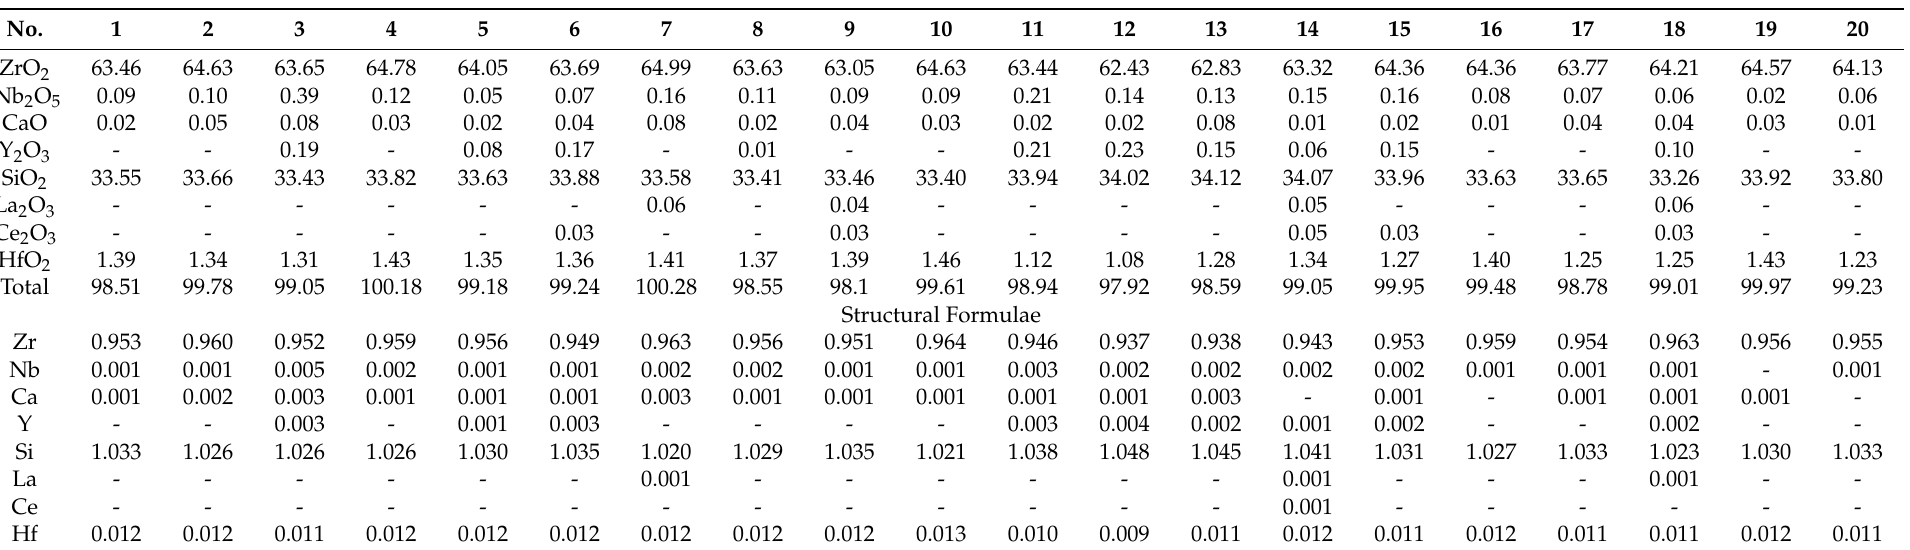
Table 2. Major elements of representative zircon of the Shuangshan nepheline syenite